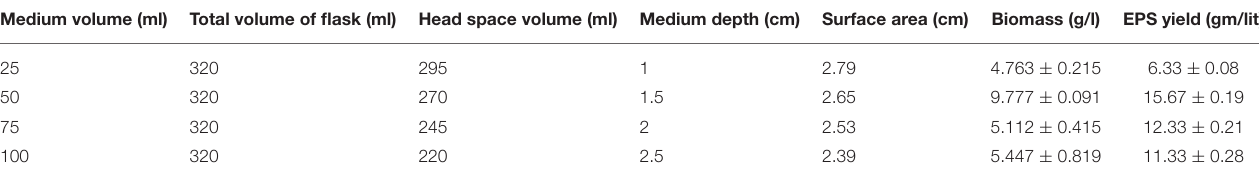
TABLE 2 | Effect of different medium volume on dissolved oxygen (DO) parameters in fermentation system with respective biomass and EPS production by Colletotrichum alatae